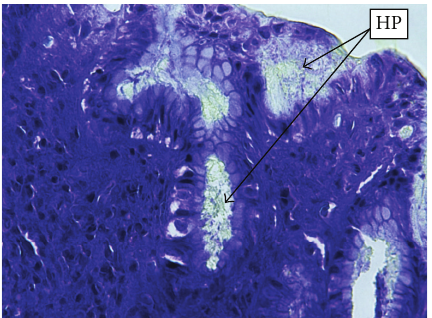
Figure 3: Healing processes after 7-day therapy: marked reduction of vacuolising lesions, restoring of foveolar architecture, reduction of inflammatory reaction, and persistence of HP colonies. (Alcian yellow; 20x